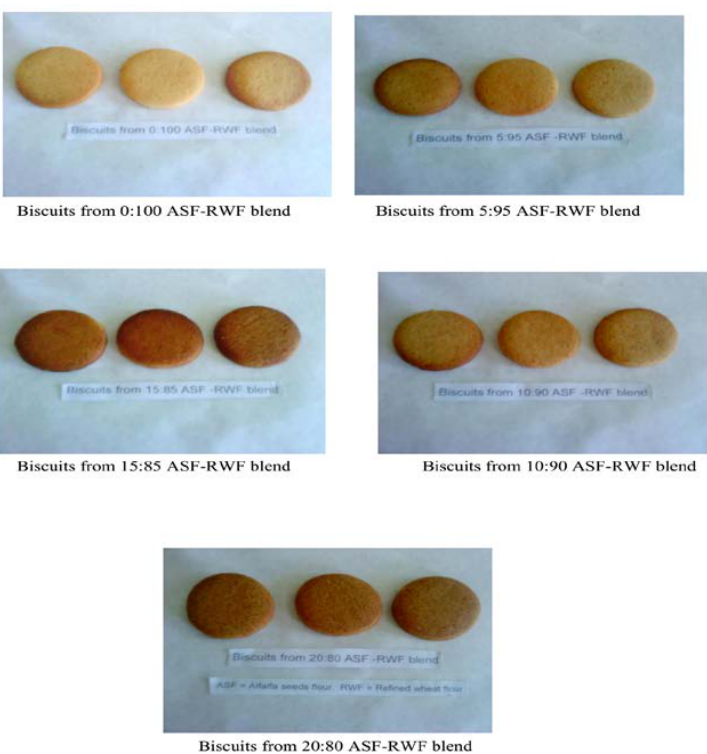
Figure 1. Control and alfalfa seed flour–supplemented biscuits. Table 6. Sensory evaluation of control and supplemented biscuits.